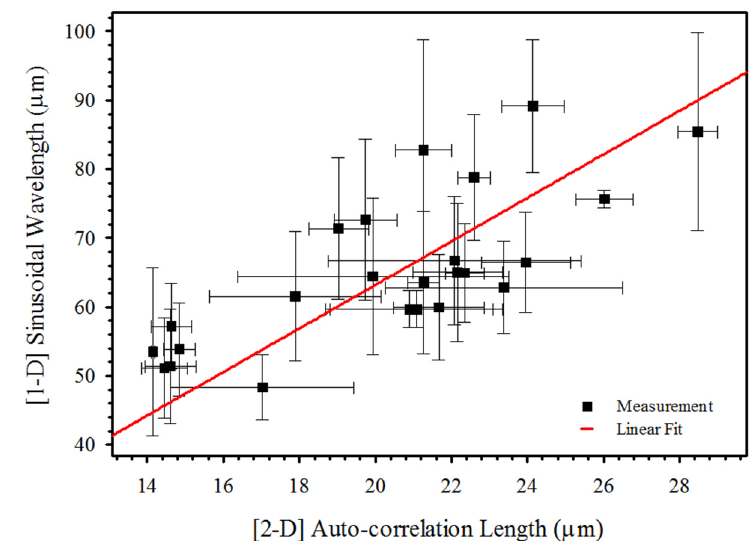
Figure 4. PMMA wrinkle measurements by one- and two-dimensional analysis methods. ( A ) PMMA surface wrinkle amplitude made by one-dimensional sinusoidal fits plotted versus two-dimensional RMS roughness. The slope and standard error are 1.34 ± 0.06. ( B ) Wrinkle wavelength made by one-dimensional sinusoidal fits plotted versus two-dimensional ACL. The slope and standard error are 3.16 ± 0.08. Vertical and horizontal error bars represent a standard deviation of at least ten sinusoidal fits and four RMS or ACL measurements.